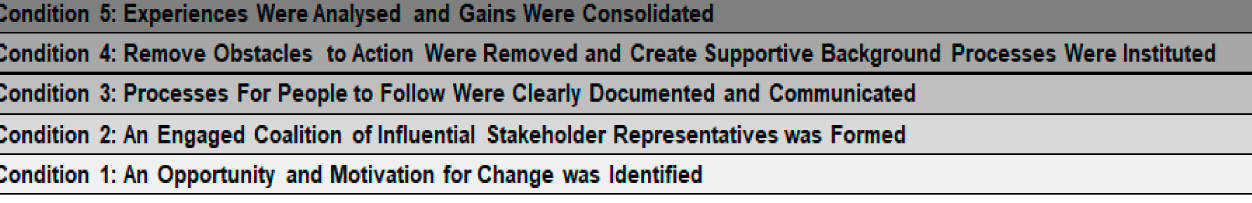
Figure 1. Conditions during the pandemic that facilitated the use of neoadjuvant therapy for breast